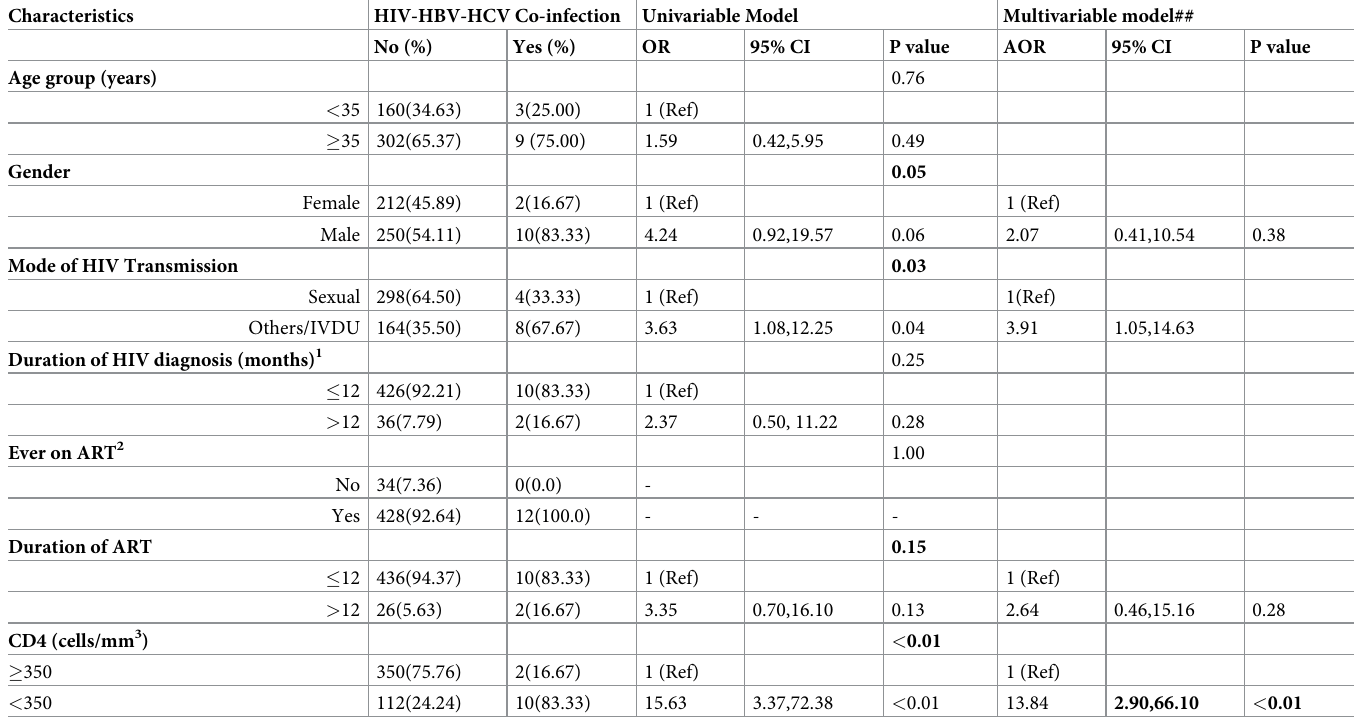
Table 4. Proportion and odds ratios of HIV-HBV-HCV co-infections in HIV patients (N = 474).